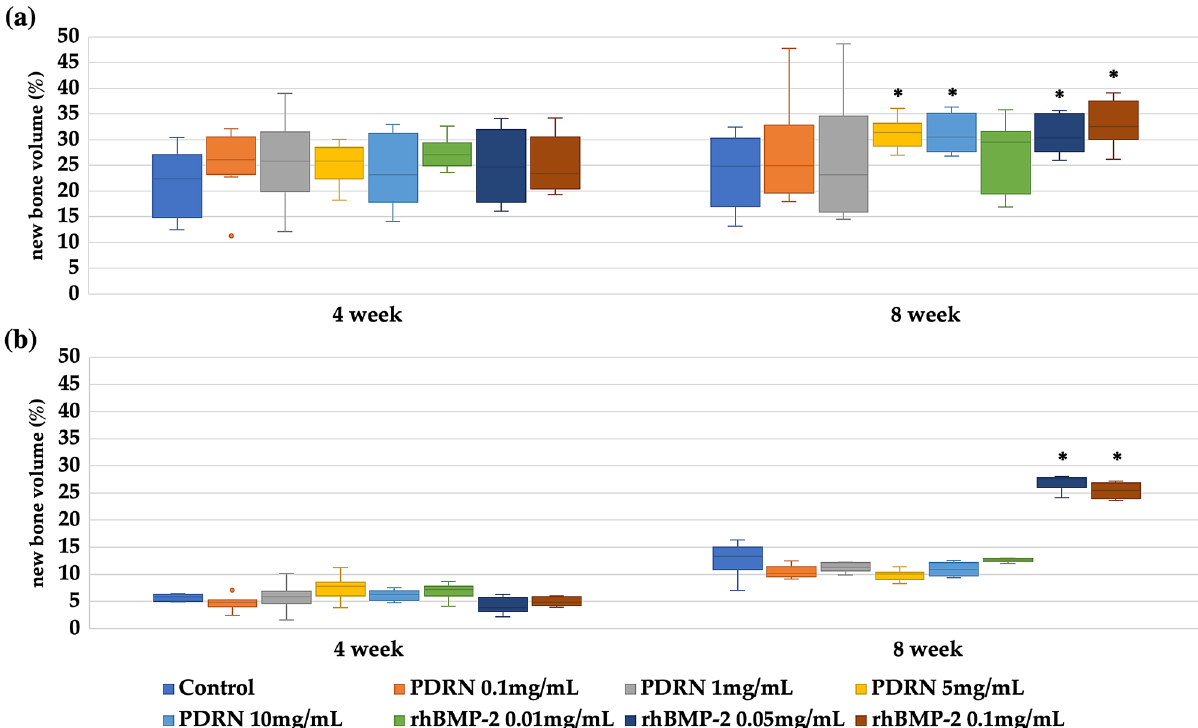
Figure 1. New bone formation in response to HA/TCP scaffolds with variable concentrations of PDRN and rhBMP-2 ( n = 16, for each). ( a ) Radiological analysis; ( b ) histomorphometric analysis; *statistically significant ( p < 0.05); box plot, 1st/3rd quartile; PDRN polydeoxyribonucleotide; rhBMP-2 recombinant human bone morphogenic protein.